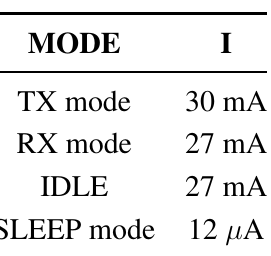
Table 2. Radio current consumption.